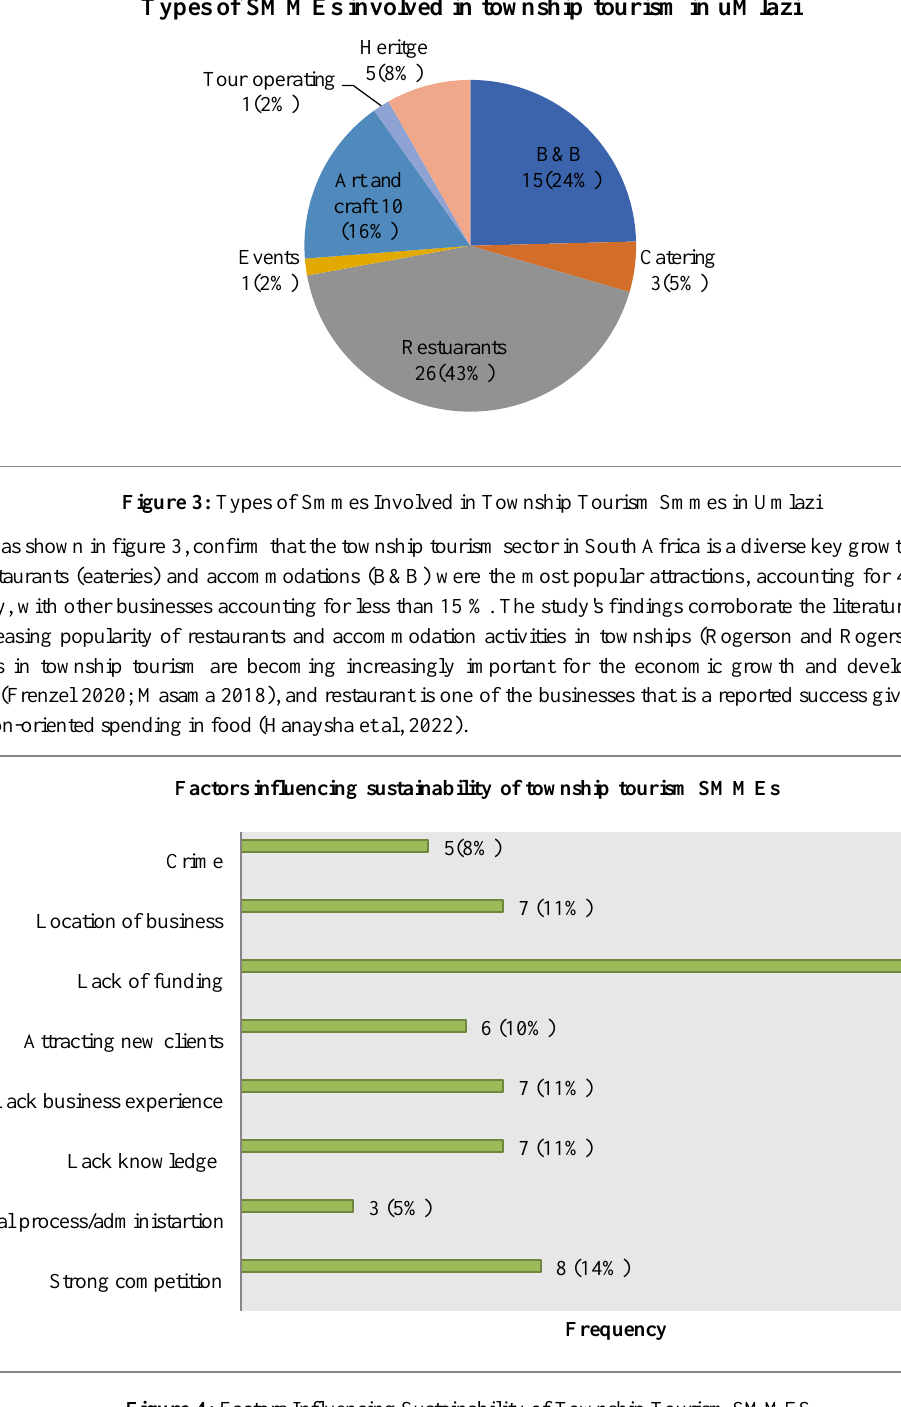
Figure 4: Factors Influencing Sustainability of Township Tourism